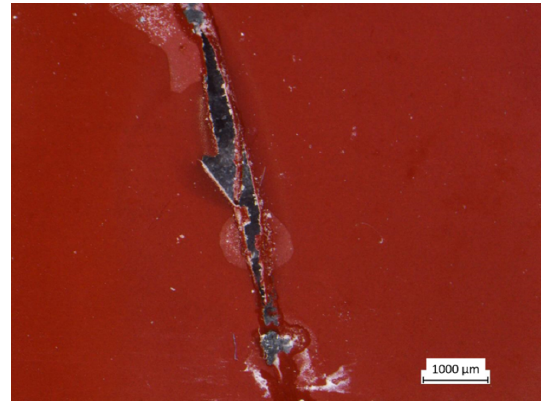
Figure 9. Crack on the surface of sample Red-N after the fourth degradation cycle.